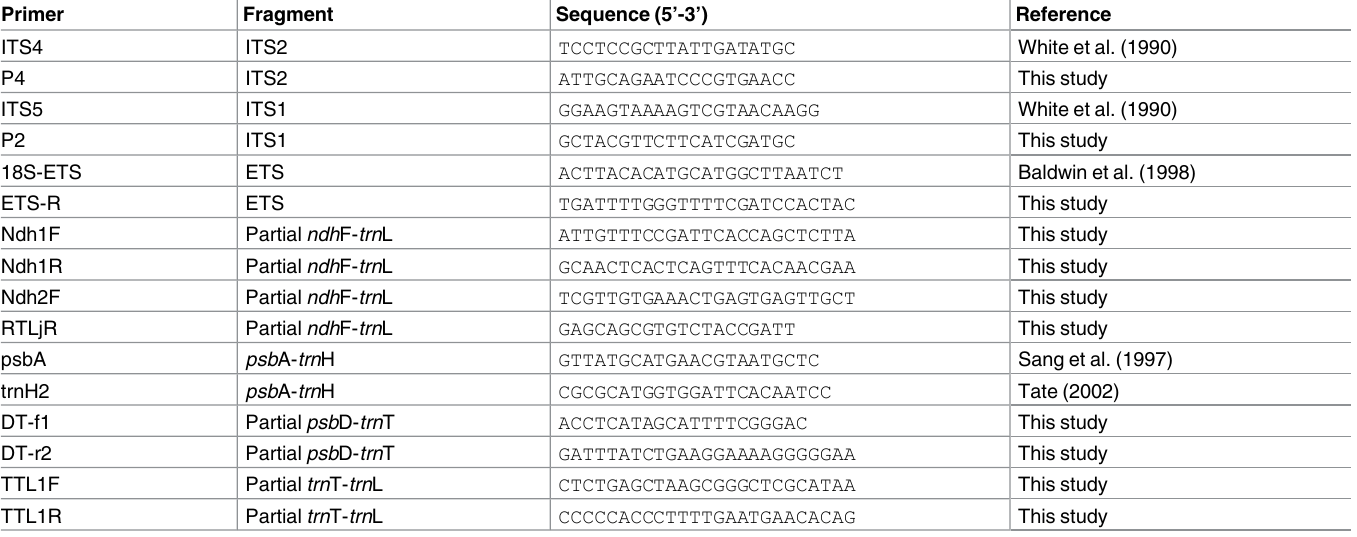
Table 2. A list of the primers used in this study.